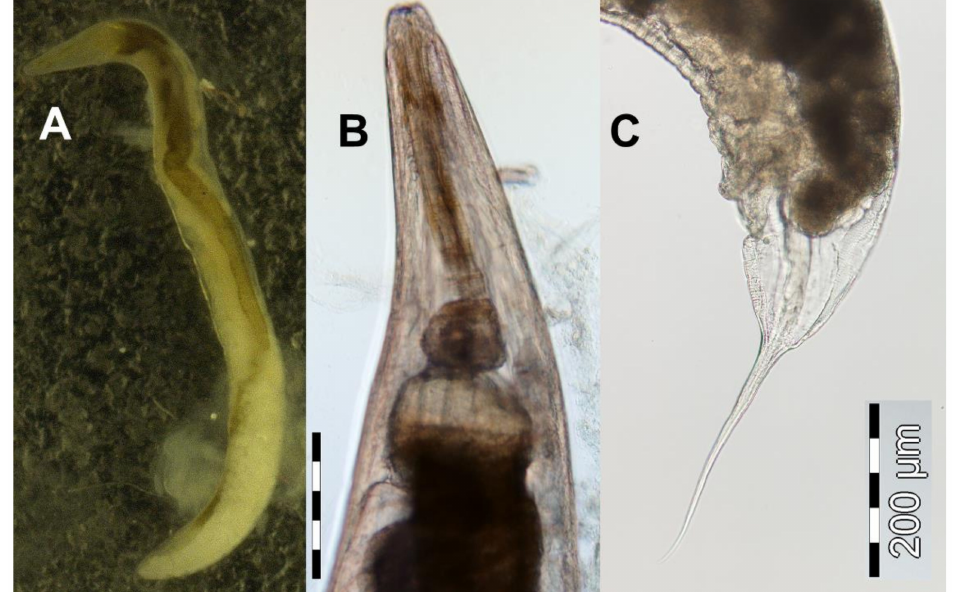
Figure 3. ( A ) Live Aplectana chamaeleonis female (6.1 mm body length) from the large intestine of a H. kivuensis male. ( B ) Lateral view on the anterior end. ( C ) Lateral view on the posterior end. Scales are given in ( B , C ) are 200 µ m. Bayesian tree of 18S-ITS1 rDNA sequences of closest matches to the